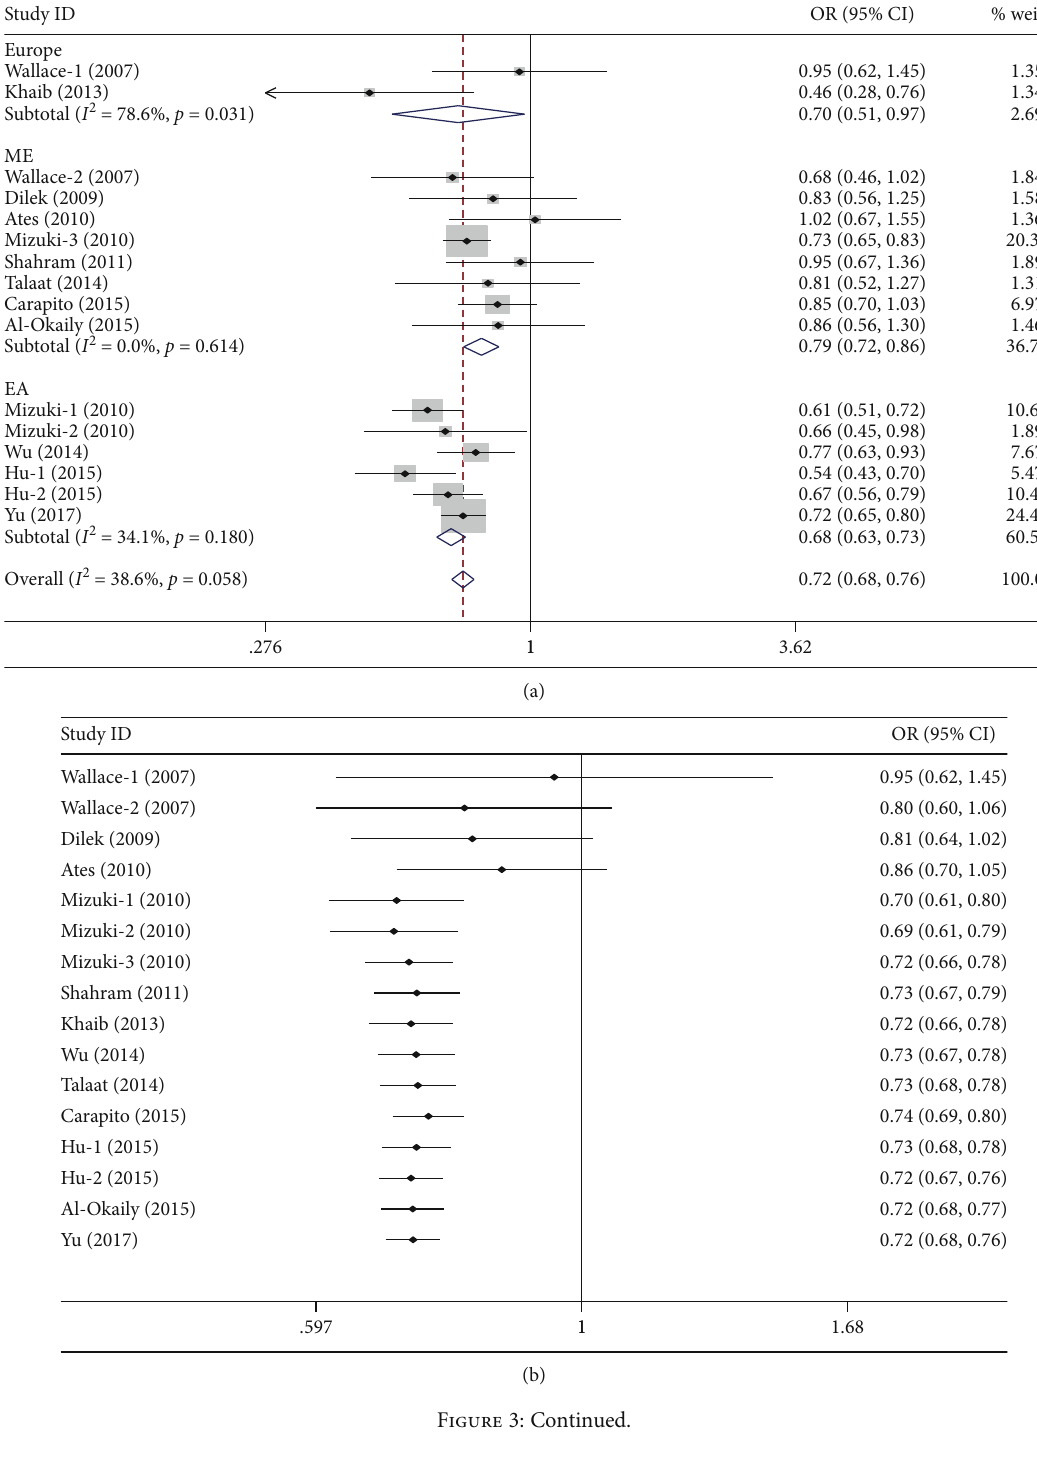
Overall ( I 2 = 38.6%, p